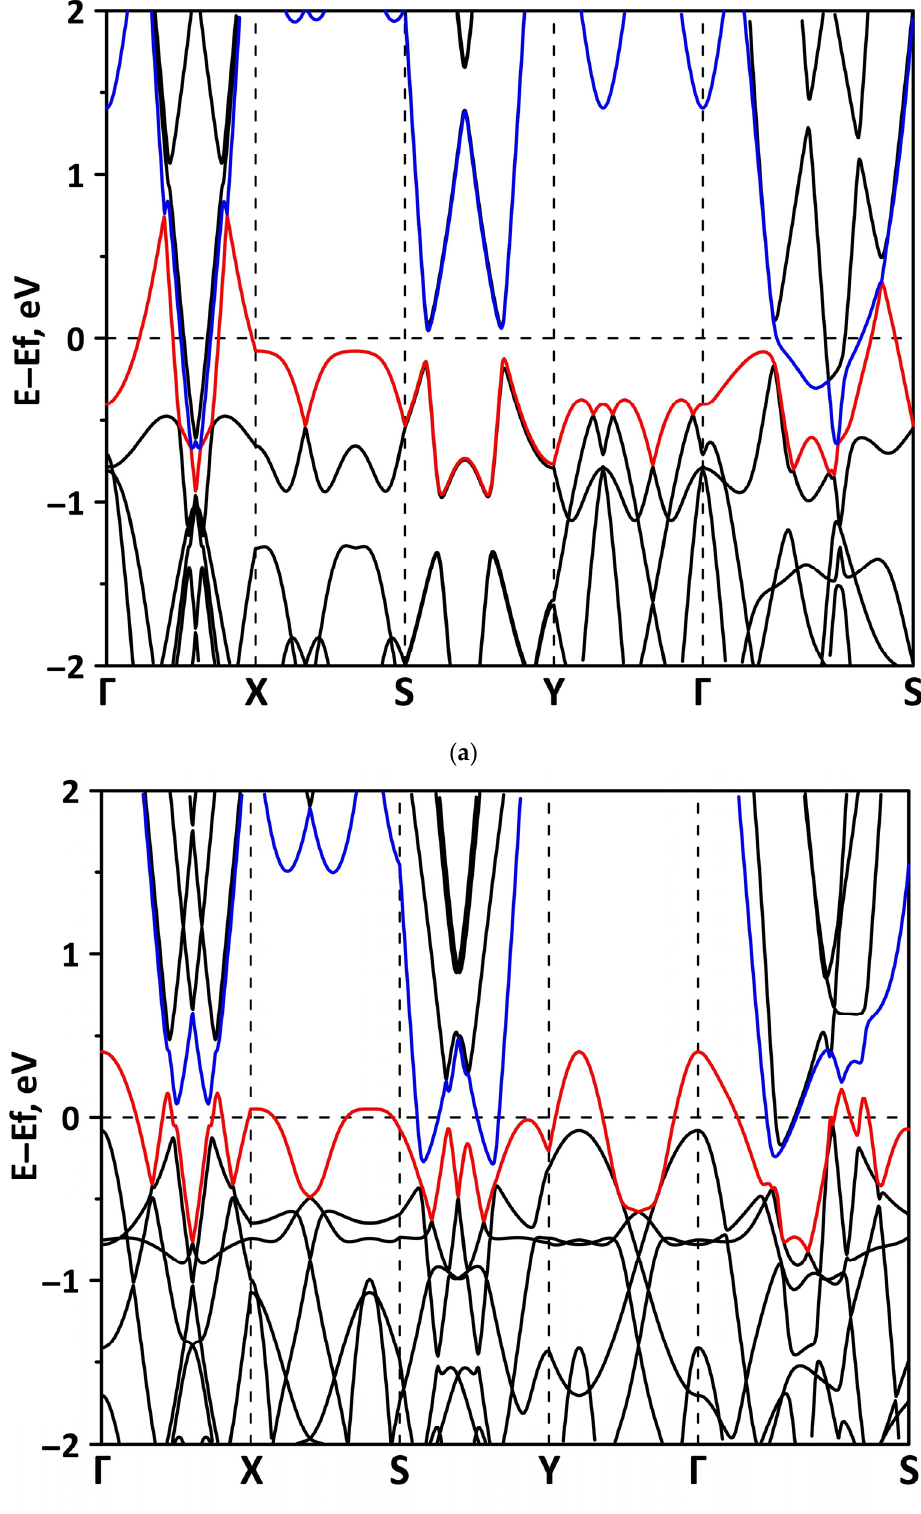
Figure 6. Fragments of the band diagrams near the Fermi level (shifted to 0 eV) of borophene/GaN heterostructure under uniaxial compression by 1% ( a ) and 14% ( b ). The VBM is highlighted in red and the CBM is highlighted in blue.